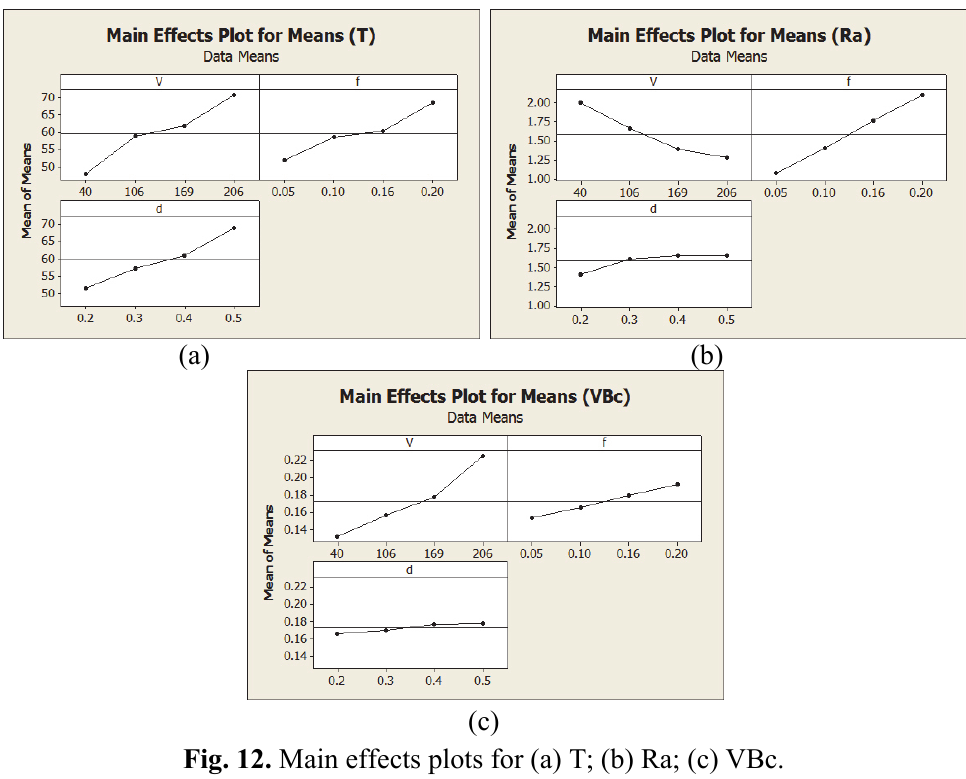
Fig. 12. Main effects plots for (a) T; (b) Ra; (c)